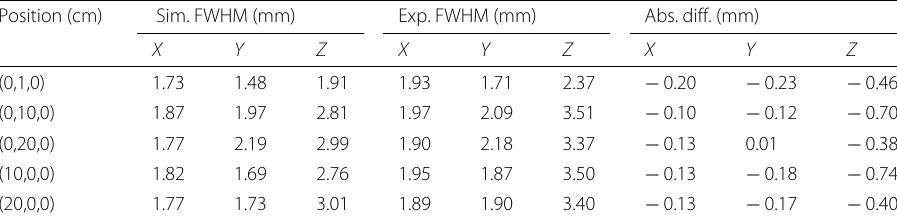
The columns to the right give their absolute